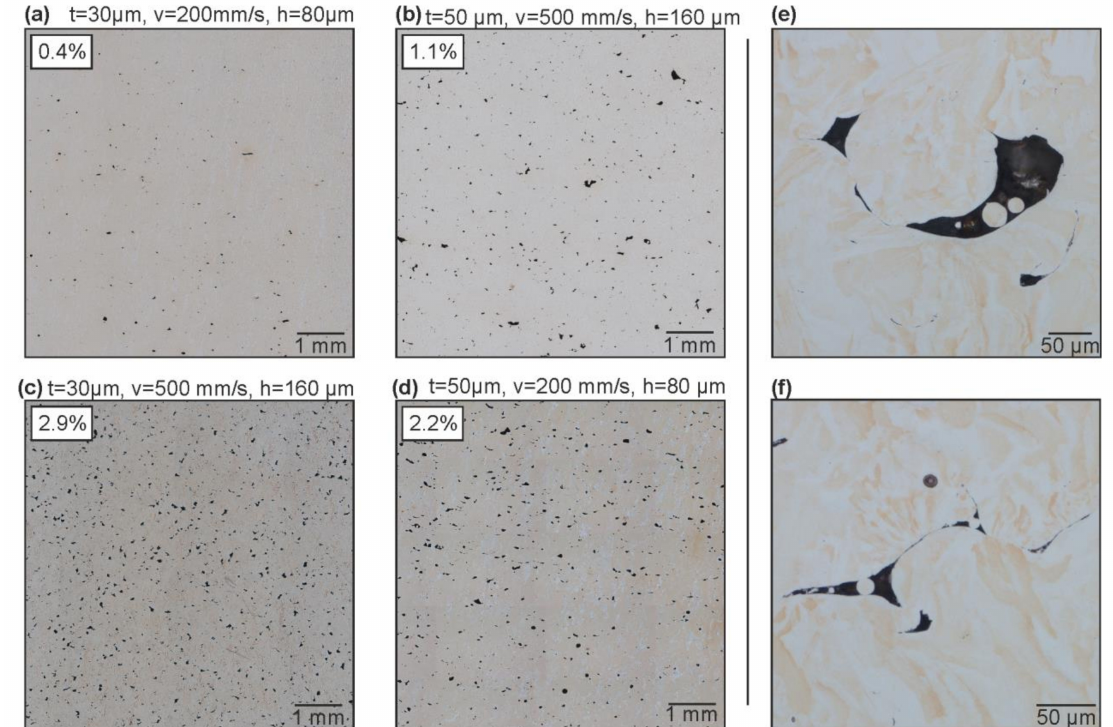
Figure 4. Examples of typical pore shapes obtained with P = 400 W and di ff erent layer thicknesses t = 30 µ m ( a , d ) and t = 50 µ m ( b , c ). LOM of specimens manufactured with P = 400 W, v = 500 mm / s, and t = 50 µ m ( e , f ). The total porosity determined from the microsections is presented on the top left of each